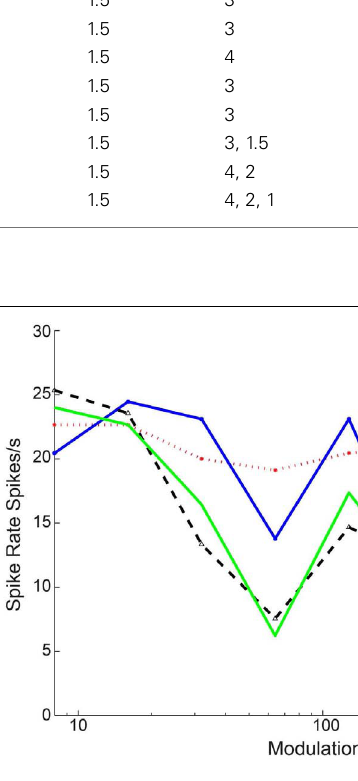
FIGUREA3 | Inhibition timing can affect rMTF response shape. Three VCN excitatory and three DNLL all-pass tuned inhibitory inputs to an Adapting model. Inhibitory inputs adjusted such that they are conincident (green) or precede excitation by 1, 3, or 5ms (black, blue, red